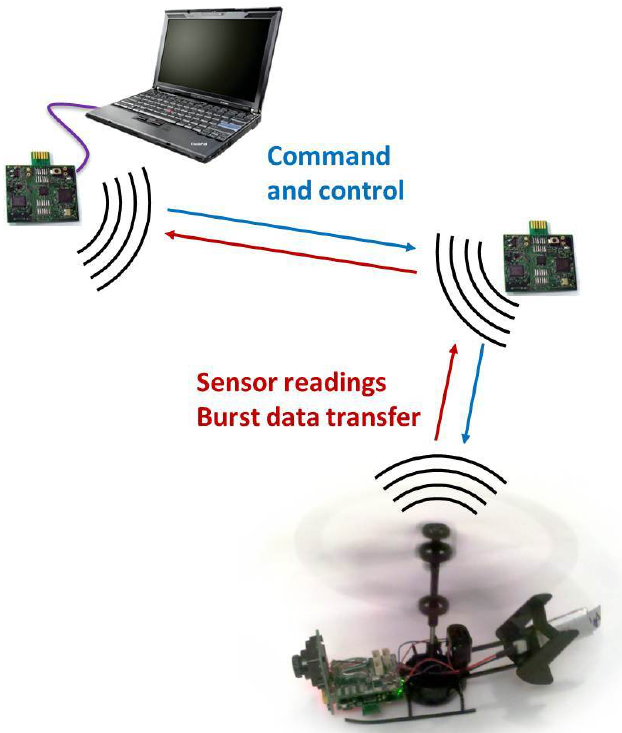
Figure 1. This schematic shows a deployed wireless sensor network infrastructure for a MAV mission. The laptop represents a base station and acts as a network manager, coordinating communications while serving as a sink for data generated by the MAV and sensor mesh. Data generated by the MAV is sent through the multihop